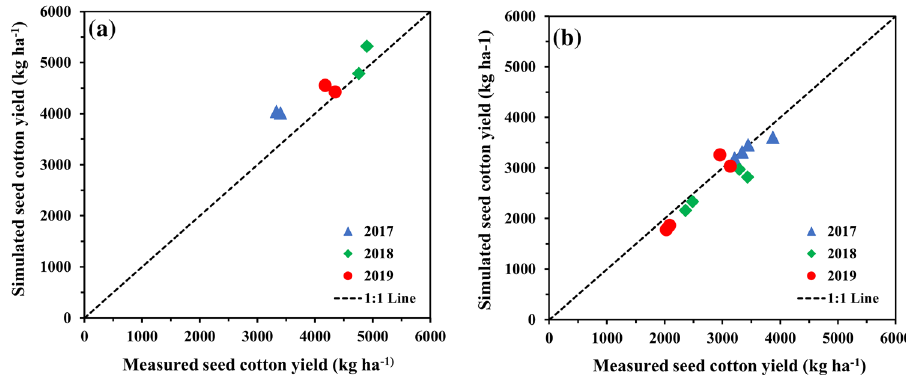
Figure 1. Comparison of measured and simulated seed cotton yield during model: ( a ) calibration, and ( b ) evaluation over 2017–2019 growing seasons.